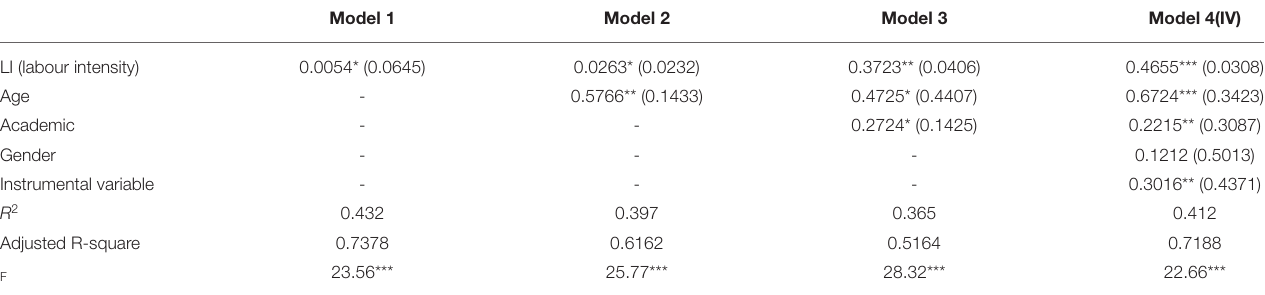
TABLE 2 | Model estimation